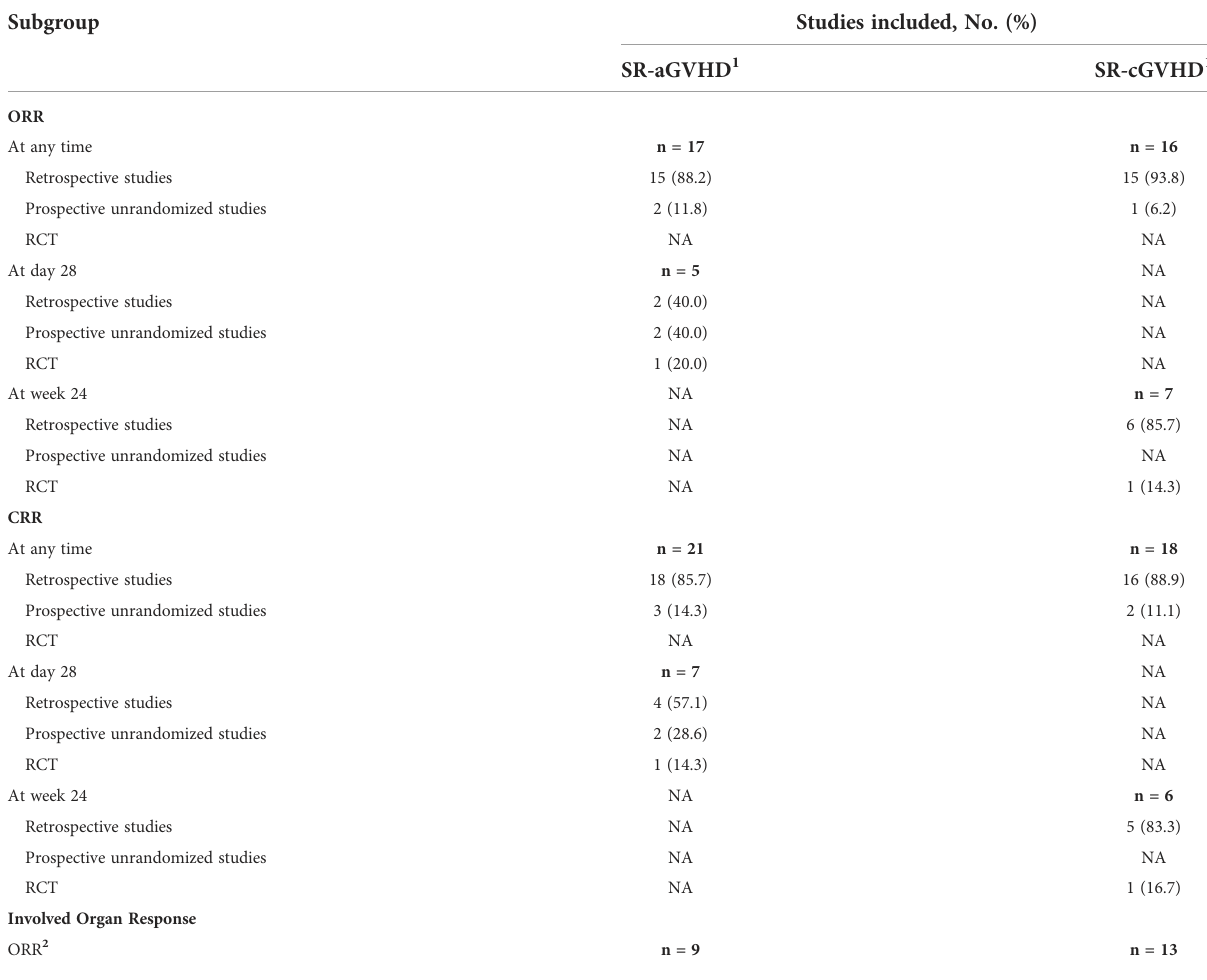
TABLE 5 The number of studies included in the subgroup analysis. Subgroup Studies included, No. (%) SR-aGVHD 1 SR-cGVHD